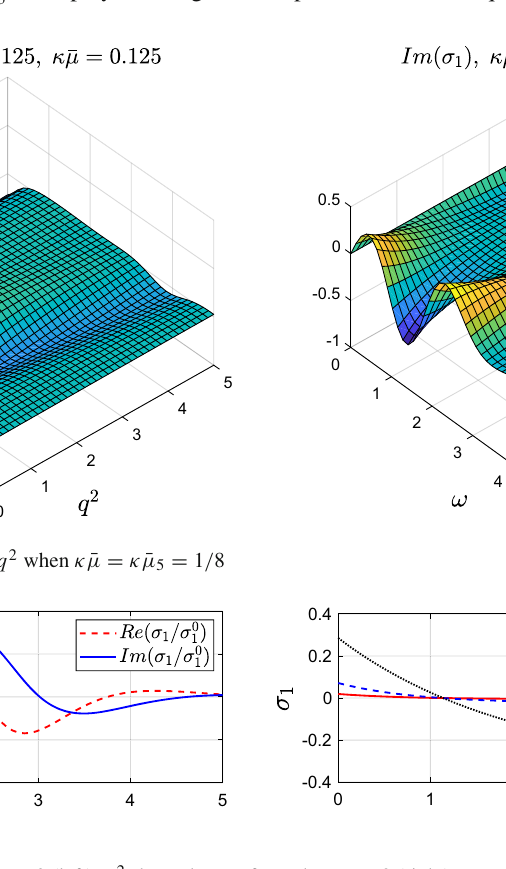
when q = 0 (left); q 2 -dependence of σ 1 when ω = 0 1